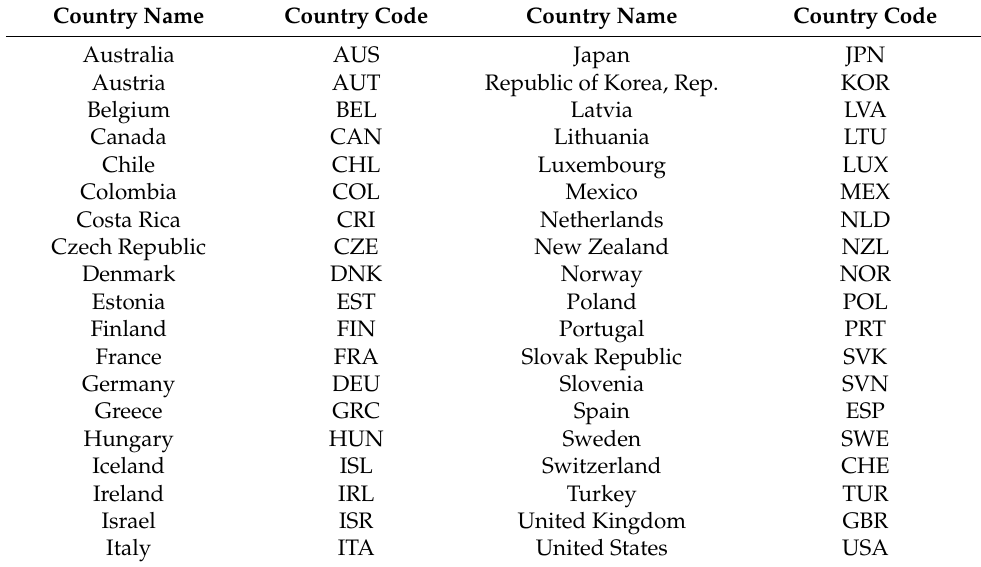
Table 1. OECD member countries.